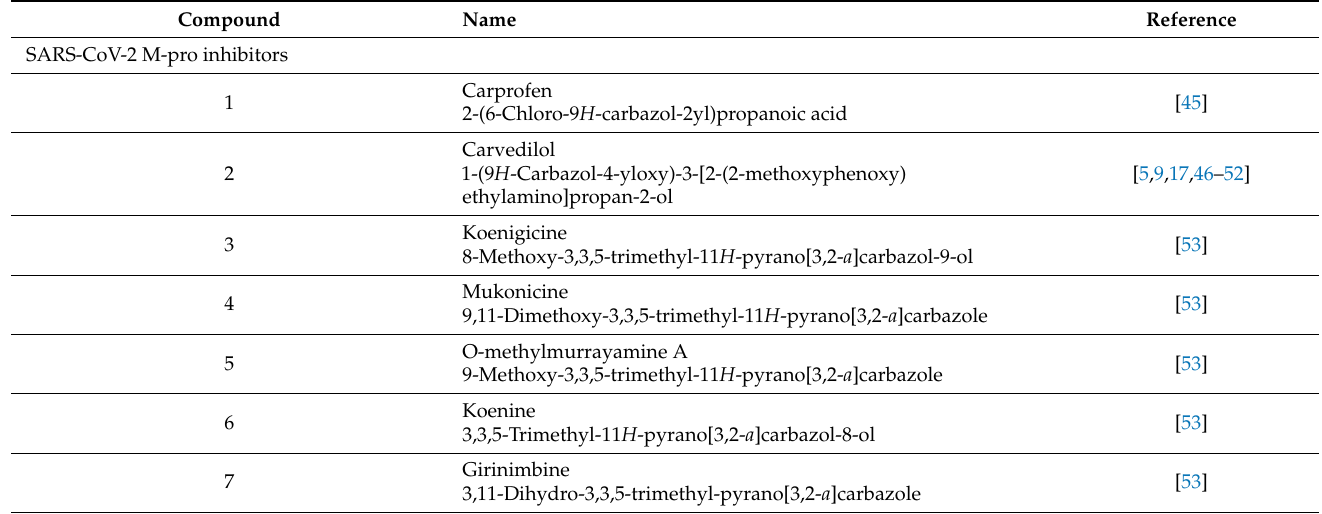
Table 1. Carbazole derivatives-based drugs for the treatment of